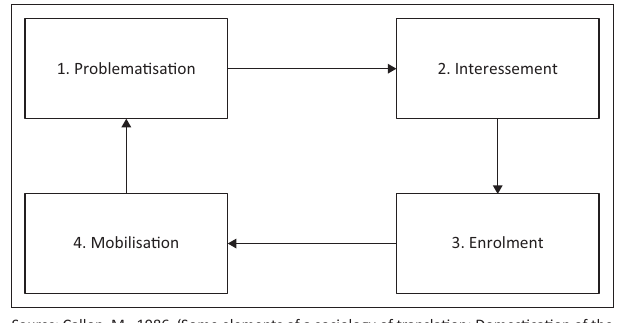
FIGURE 1: Four moments of